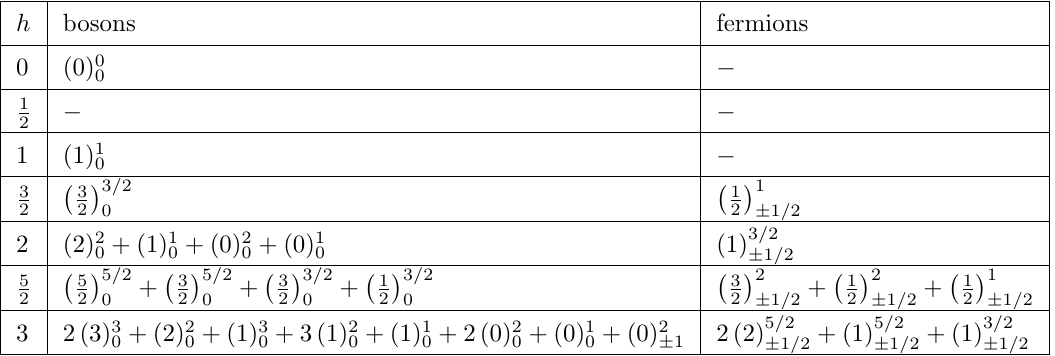
encodes the spin j r